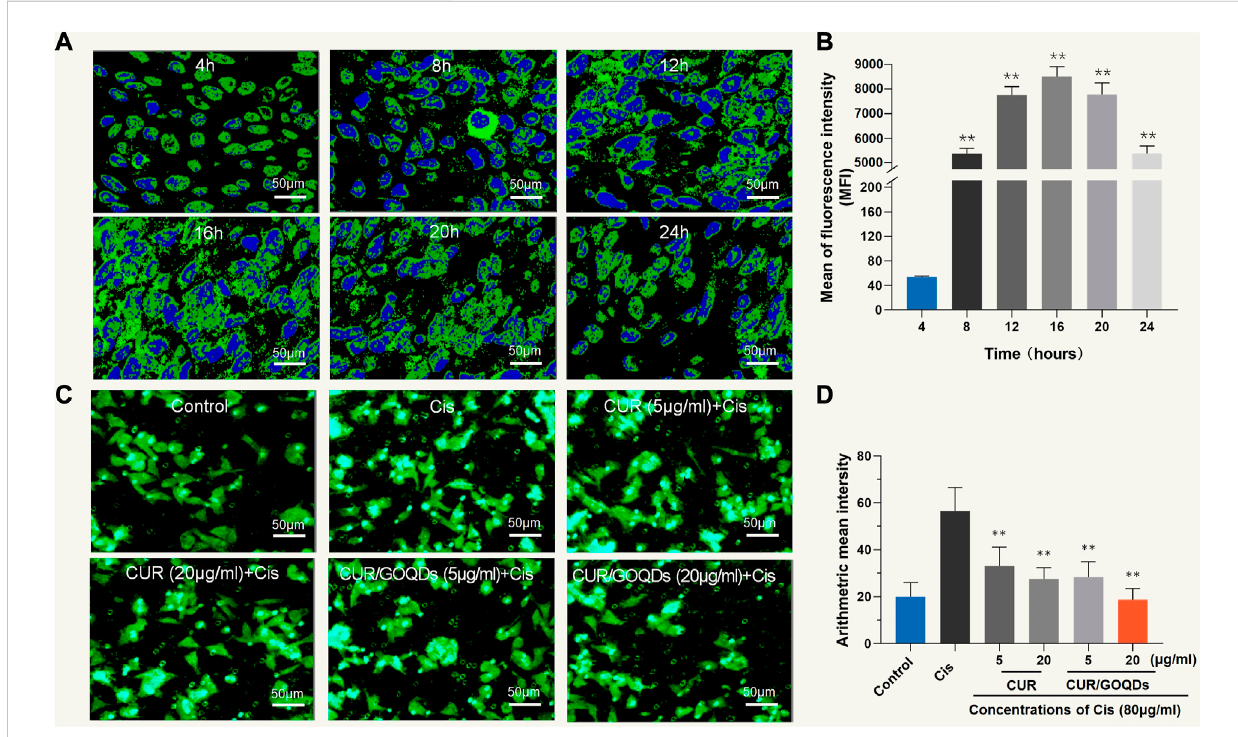
FIGURE 3 Cellular uptake of CUR/GOQDs in OC1 cells. (A) Confocal images of internalization in different periods. (B) The average fl uorescence intensity of OC1 cells was measured by fl ow cytometry. (C) ROS level detection (DCFHDA) pretreated with CUR or CUR/GOQDs (5 and 20 μ g/mL) for 6 h, followed byCIS(80 μ M,12 h).ConfocalimagesshowingDCFHDAstainedintracellularROS(green fl uorescence)increasedinOC1cellstreatedwith80 μ MCISand was signi fi cantly inhibited by CUR or CUR/GOQDs. (D) Quanti fi cation of the average fl uorescence intensity. ROS decreased signi fi cantly after the application of CUR or CUR/GOQDs. ** p <